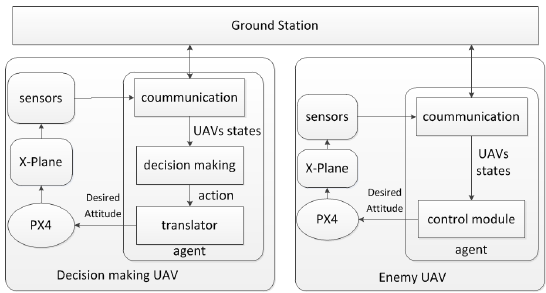
Figure 4. The structure of the simulation